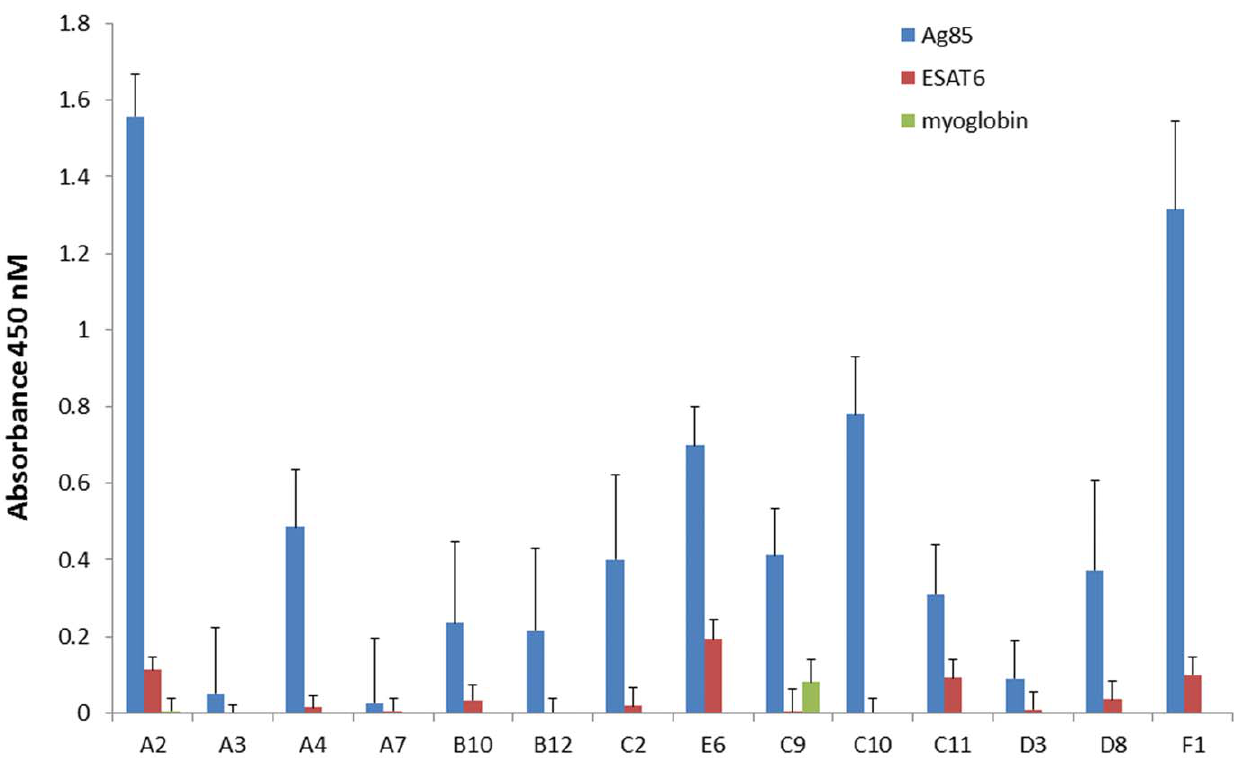
Figure 5. Enzyme linked immunosorbant assay (ELISA) of selected antibodies. 14 of the scFvs were recloned into a yeast expression vector as scFv-Fc fusions [28], using a rabbit Fc domain, and tested for recognition of Ag85 directly adsorbed to plastic in an ELISA format using standard anti-rabbit antibodies as secondary reagents.